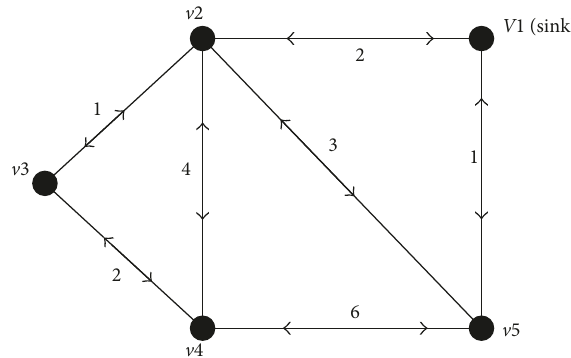
Figure 1: Model of wireless sensor network for coal mine